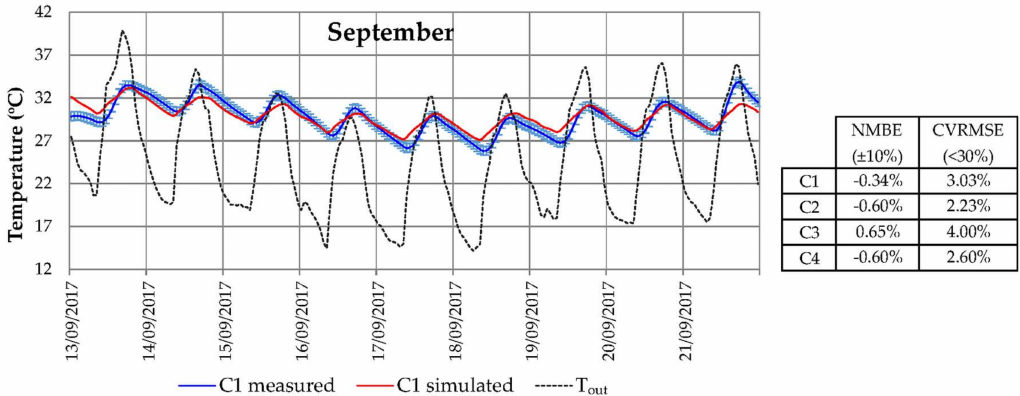
Figure 14. Validation of the energy simulation model. Mean Bias Error (MBE) and Coefficient of Variation of the Root Mean Square Error (CVRMSE) for each test cell.